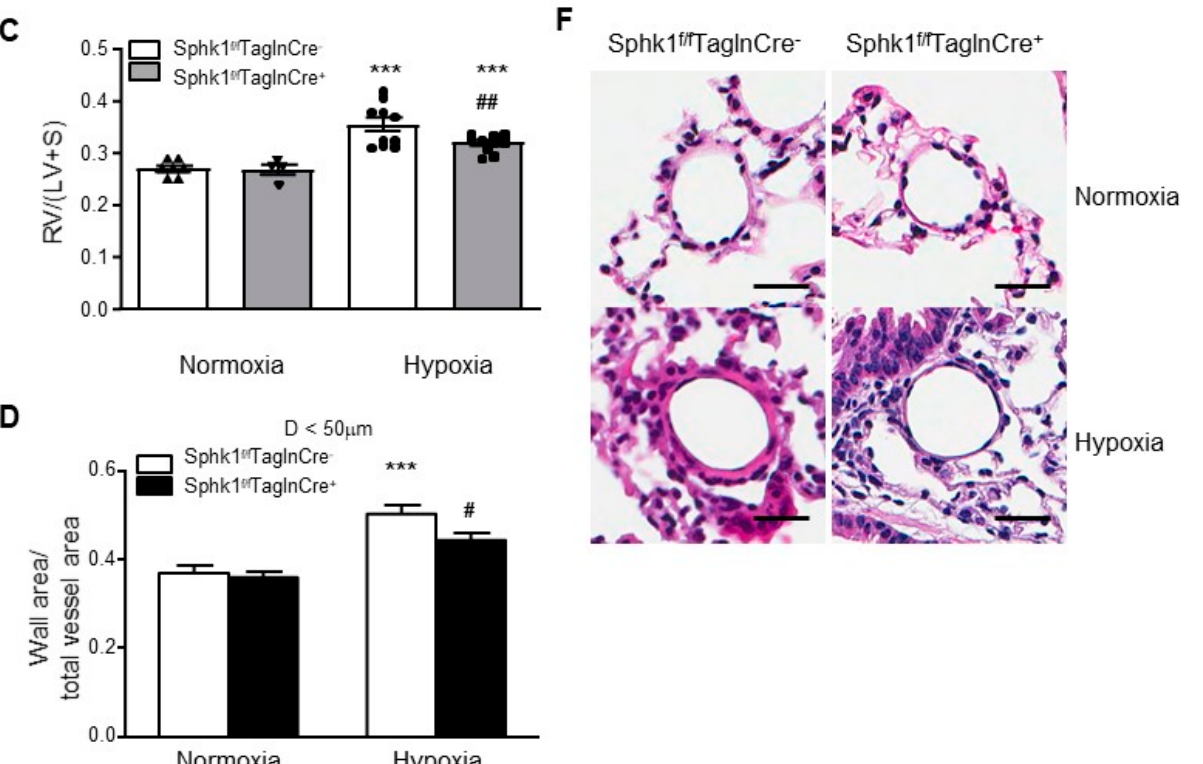
Figure 2. Smooth muscle cell-specific Sphk1 knockout ( Sphk1 f/f TaglnCre + ) mice are protected from hypoxia-induced pulmonary hypertension. When compared with their wild-type siblings ( Sphk1 f/f TaglnCre − ), Sphk1 f/f TaglnCre + mice exposed to hypoxia developed ( A , B ) less severe elevations in right ventricular systolic pressure (RVSP), ( C ) less right ventricular hypertrophy (RV/(LV + S)), and ( D ) lower increases in the ratios of wall area to the total vessel area of pulmonary arteries less than 50 µm ( E ) and 50–100 µm in diameter. ( F ) Representative pulmonary artery images in the lung sections of control and Sphk1 f/f TaglnCre + mice exposed to normoxia or hypoxia. Scalebar: 20 µm. Results are expressed as mean ± SEM; number of mice in each group ( n = 5–10) is shown in ( B , C ). *** p < 0.001 versus normoxia Sphk1 f/f TaglnCre- group; #, ##, ### p < 0.05, hypoxia Sphk1 f/f TaglnCre − vs. hypoxia Sphk1 f/f TaglnCre +